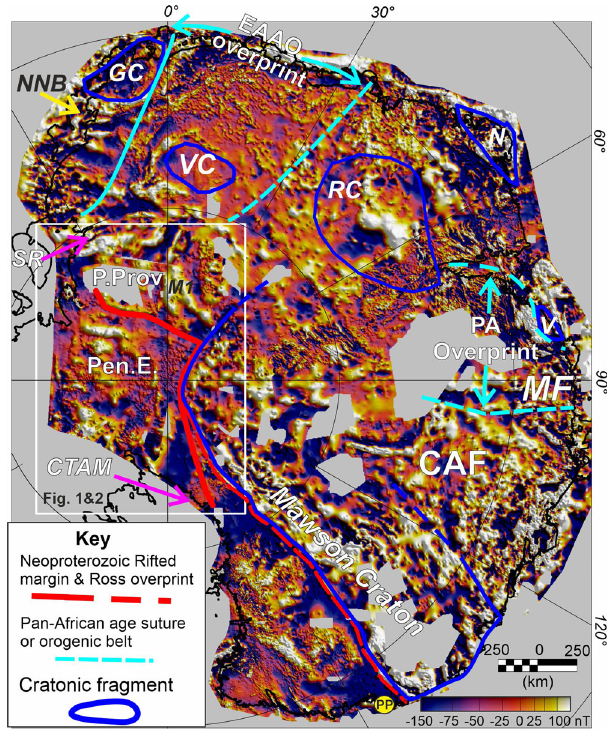
Fig. 3 Province boundaries in a wider East Antarctic context. Province boundaries overlain on East Antarctic aeromagnetic compilation from this study and ADMAP2 27 . The Mawson Continent includes the Mawson Craton, and continuations of the Australian Coompana/Albany-Fraser provinces (CAF). It is bounded by the Mirny Fault (MF) 7 and associated zone of Pan African age overprint (PA) 52,53 , the PolarGAP Province (P. Prov), and the Pensacola Embayment (Pen. E). Other cratons 54 include; Grunehogna (GC), Rucker (RC), Napier Complex (N), Valkyrie (VC), and Vestfold Hills (V). Smaller Archean provinces are not shown. Note Namaqua Natal Belt (NNB) formed by accretion of island arc terrains against the Grunehogna Craton, prior to collision between African- Antarctic provinces with the wider East Antarctic continent along the broad East African Antarctic Orogeny (EAAO) 8 . Yellow circle (PP) marks Ross age granites exposed at Penguin Point de fi ning the inboard extent of the >500 km wide Ross Orogen 36